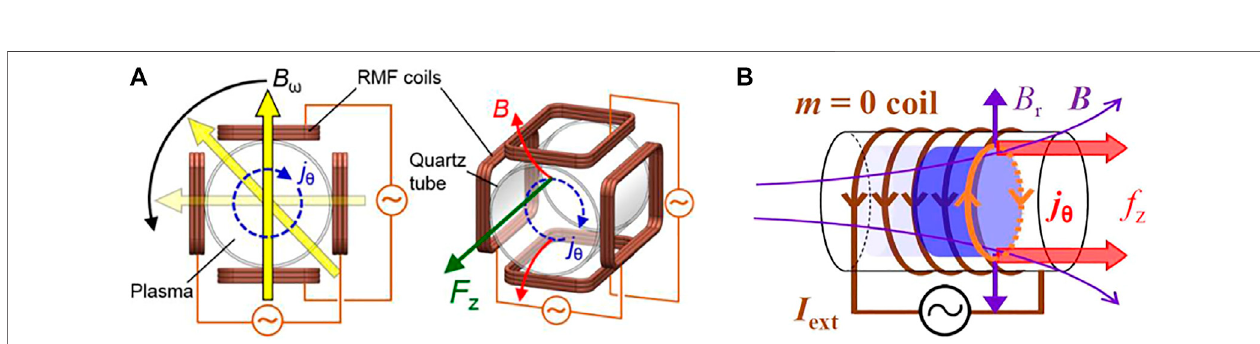
FIGURE 9 | Electrodeless acceleration schemes: (A) rotating magnetic fi eld, reproduced from [54], with the permission of JSPF; (B) m (cid:3) 0 half cycle, reproduced from [56], with the permission of IEEE Publishing.